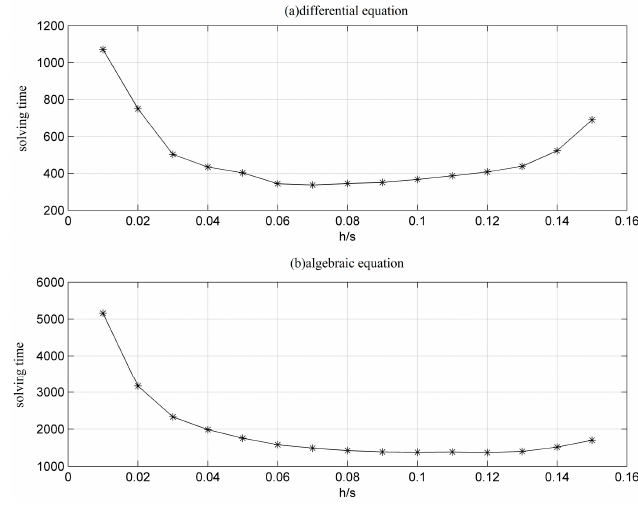
Figure 10. The amount of computing for differential algebraic equations in case C.